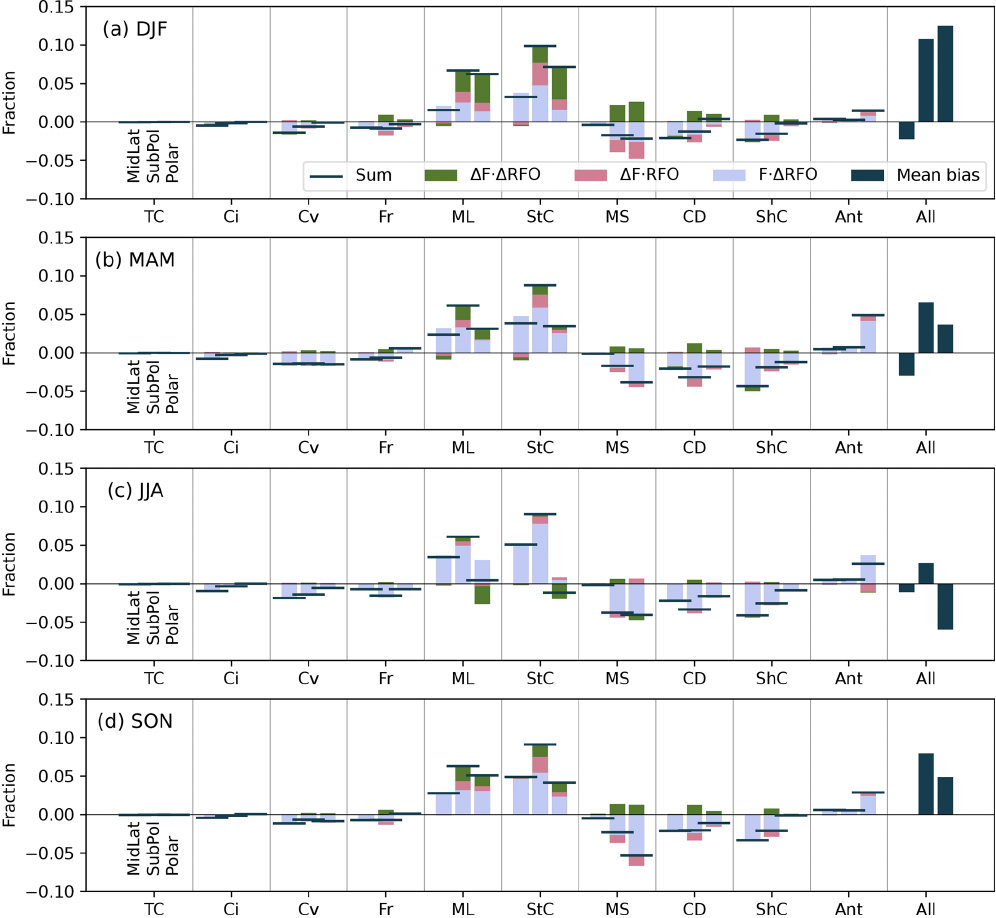
Figure A2. The decomposed mean biases in the CFI (fraction) for each cloud regime (thin cirrus, TC; cirrus, Ci; convective, Cv; frontal, Fr; mid-level, ML; stratocumulus, StC; marine stratiform, MS; cloud decks, CD; shallow cumulus, ShC; Antarctic, Ant) over the three regions from left to right mid-latitudes, sub-polar and polar, for each season (DJF, a ; MAM, b ; JJA, c ; SON, d ). The sum of the decomposed biases is shown by the horizontal bar, while the terms of the bias decomposition (see Eq. 1) are shown in blue ( F sat r · (cid:49) RFO r ), pink ( (cid:49)F r · RFO sat r ) and green ( (cid:49)F r · (cid:49) RFO r ). On the far right of each plot is the mean radiative bias for each region/season as a reference.